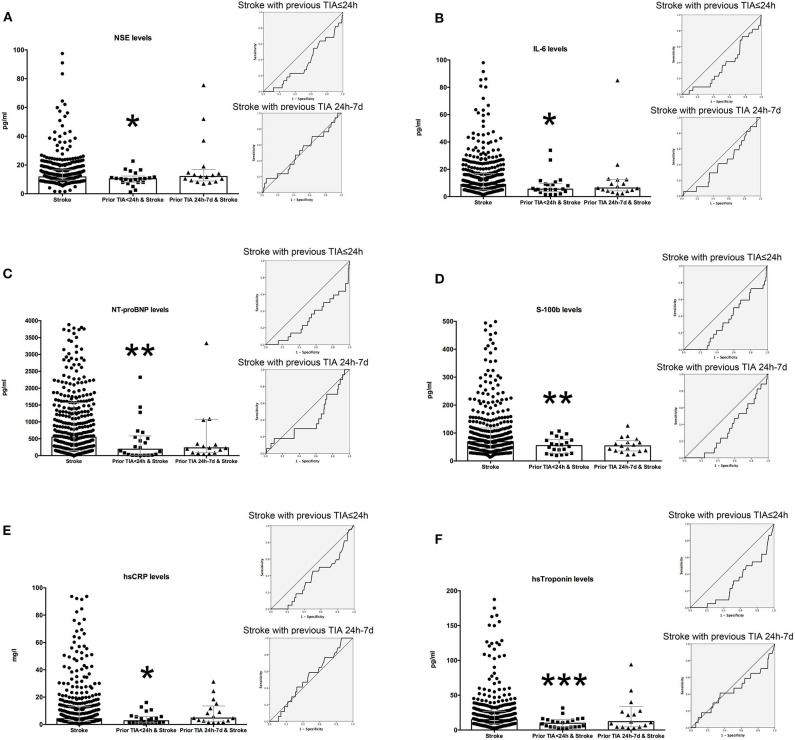
Plasma levels of inflammatory markers according to preconditioning induced by TIA. The levels of NSE (A), IL-6 (B), NT-proBNP (C), S-100b (D), hsCRP (E), and hsTroponin (F) were determined by chemiluminescence immunoassay. Differences in levels of inflammatory markers were analyzed using non-parametric test with p < 0.05 being significant. Graphs represent median with interquartile range (gray color). Receiver operating characteristic (ROC) curve for stroke with previous TIA ≤ 24 h and stroke with previous TIA (24 h−7 d) were an insert for each biomarker. Area under the curve (AUC) for NSE is 0.359, p = 0.026 for previous TIA ≤ 24 h; and 0.507, p = 0.921 for previous TIA 24 h−7 d. AUC for IL6 is 0.358, p = 0.024 for previous TIA ≤ 24 h; and 0.415, p = 0.236 for previous TIA 24 h−7 d. AUC for NT proBNP is 0.303, p = 0.002 for previous TIA ≤ 24 h; and 0.408, p = 0.200 for previous TIA 24 h−7 d. AUC for S100B is 0.344, p = 0.014 for previous TIA ≤ 24 h; and 0.342, p = 0.027 for previous TIA 24 h−7 d. AUC for hsCRP is 0.374, p = 0.046 for previous TIA ≤ 24 h; and 0.529, p = 0.689 for previous TIA 24 h−7 d. AUC for hs troponin is 0.298, p = 0.001 for previous TIA ≤ 24 h; and 0.443, p = 0.427 for previous TIA 24 h−7 d. *p-value between 0.025 and 0.05; **p-value between 0.01 and 0.025; ***p < 0.01.